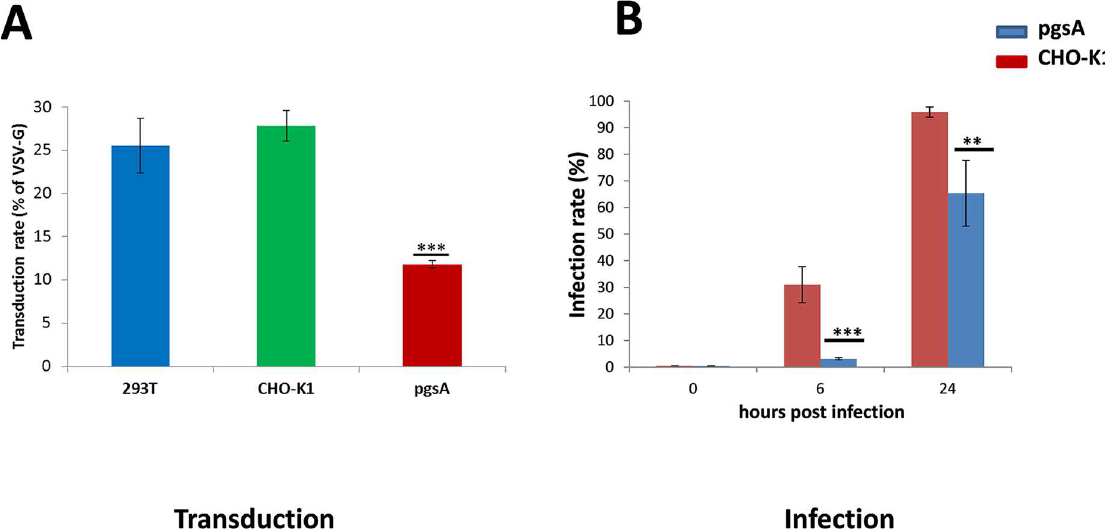
Fig 1. Transduction or infection of cells with CHIKV Env pseudotyped vector particles. A: 293T, CHO-K1, and pgsA-745 cells were seededin 24-wellplates and transduced with gfp -encoding CHIKV Env-pseudotyped lentiviral vector particles. The cells were analyzedby flow cytometry for GFP expression48 hrs post transduction. The proportionof GFP-positive cells is given relative to the proportionof positive cells followingtransduction with VSV-G-pseudotyped vectors (control). Data representthe averageof three independentexperiments. *** (P (cid:20) 0.001) indicatessignificantdifferences in transduction rates comparedto CHO-K1 cells. B: CHO-K1 and pgsA-745cells were seeded in 24-wellplates and infected with CHIKV-mCherry at an MOI of 1. The viral replication was determined6 and 24 hrs post-infection, respectively,by flow cytometry detectingmCherry. Data represent the averageof three independent experiments. ** and *** indicatesignificantdifferencesin infection rates to CHO-K1 cells after 6 and 24 hrs, respectively. * (P (cid:20) 0.05) and ** (P (cid:20)